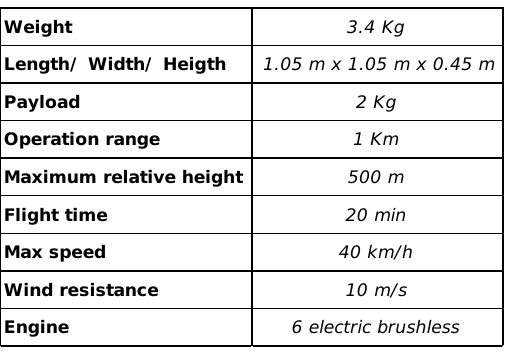
Table 1. Technical specifications of Aibot X6